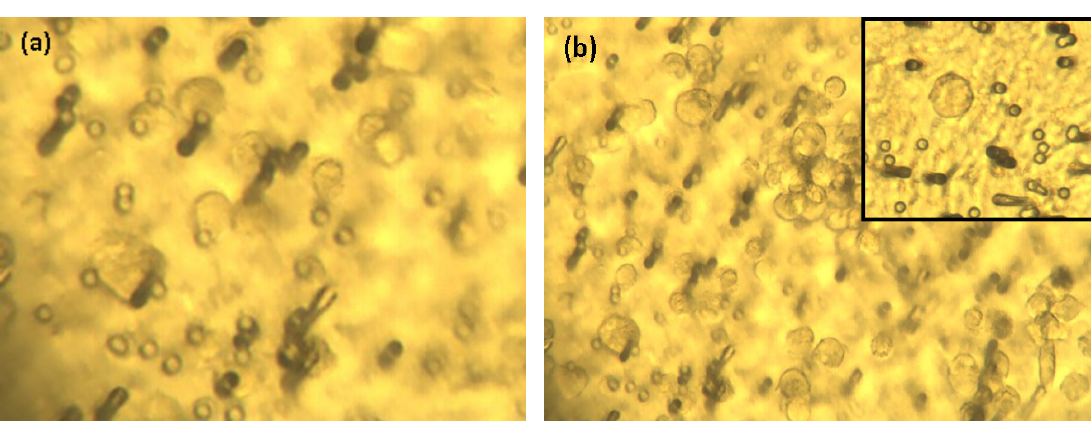
Figure 5. CFSE proliferation assay results. Count of cells vs . the fluorescence intensity